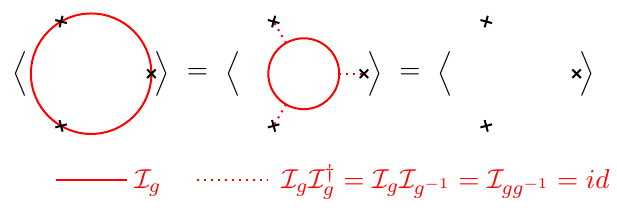
Figure 3 . Three-point function on group-like defects for bulk fields. One can shrink the defect circle to zero which in the vacuum expectation value gives a factor of g defect is not group like the dotted line is not simply the identity and can carry additional repre- sentations/fields that can appear in channels of higher point